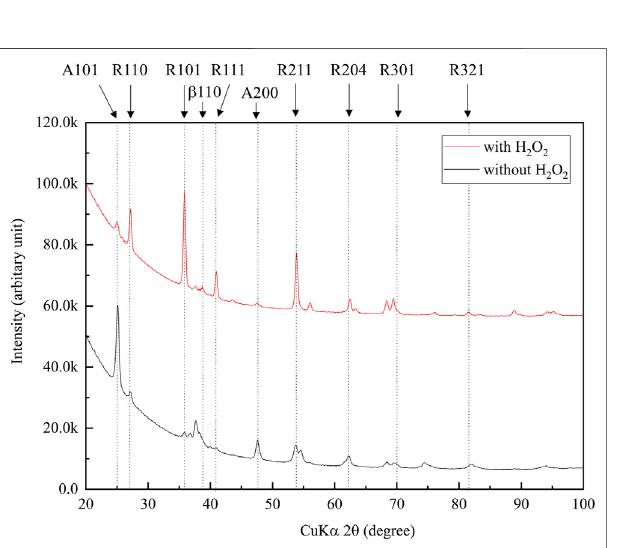
Frontiers in Bioengineering and Biotechnology |